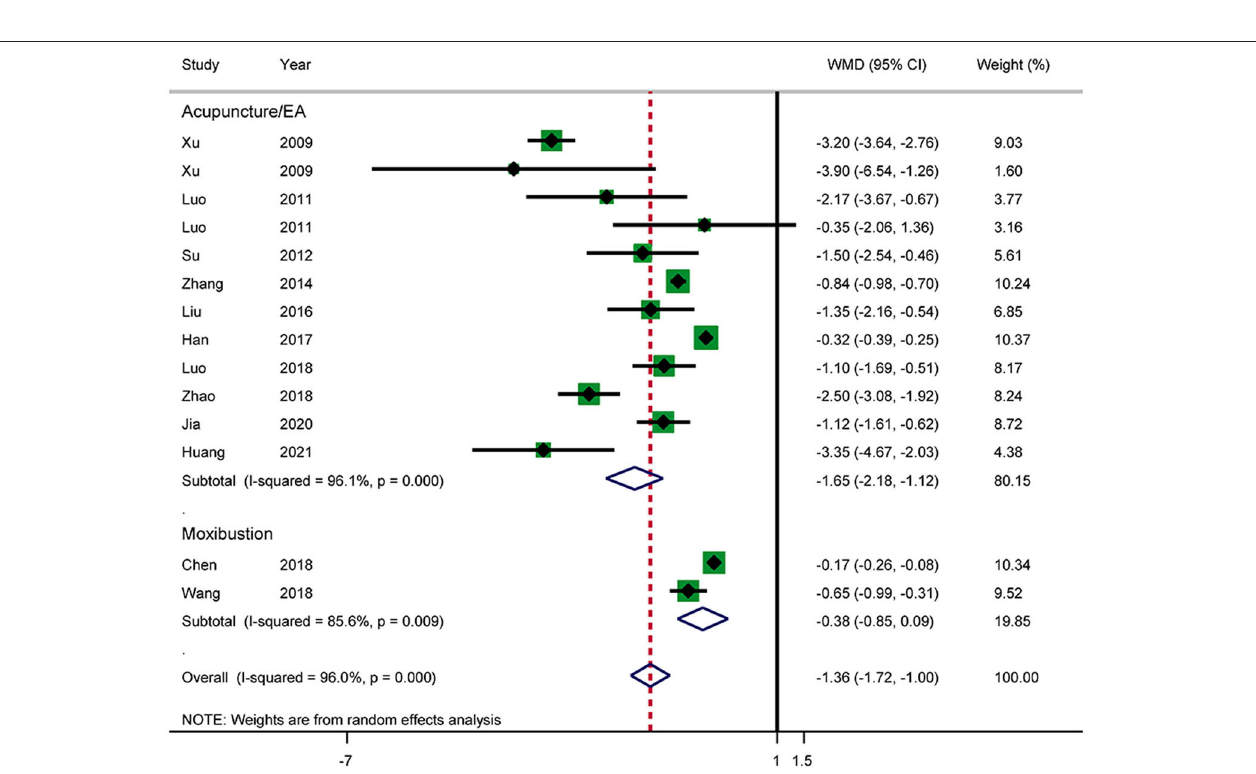
FIGURE 6 | Meta-analysis of time until relief of abdominal